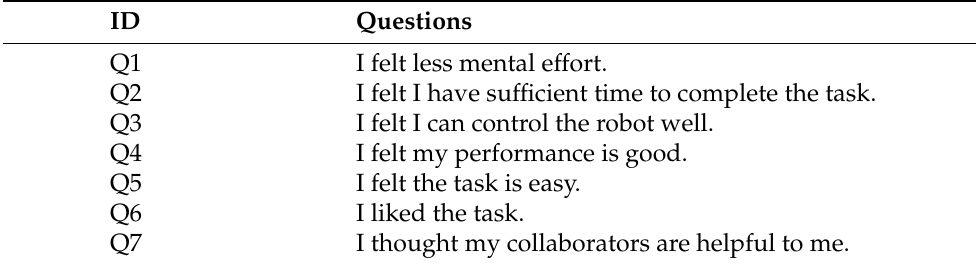
Table 1. Questionnaire for human–human and human–agent control modes.